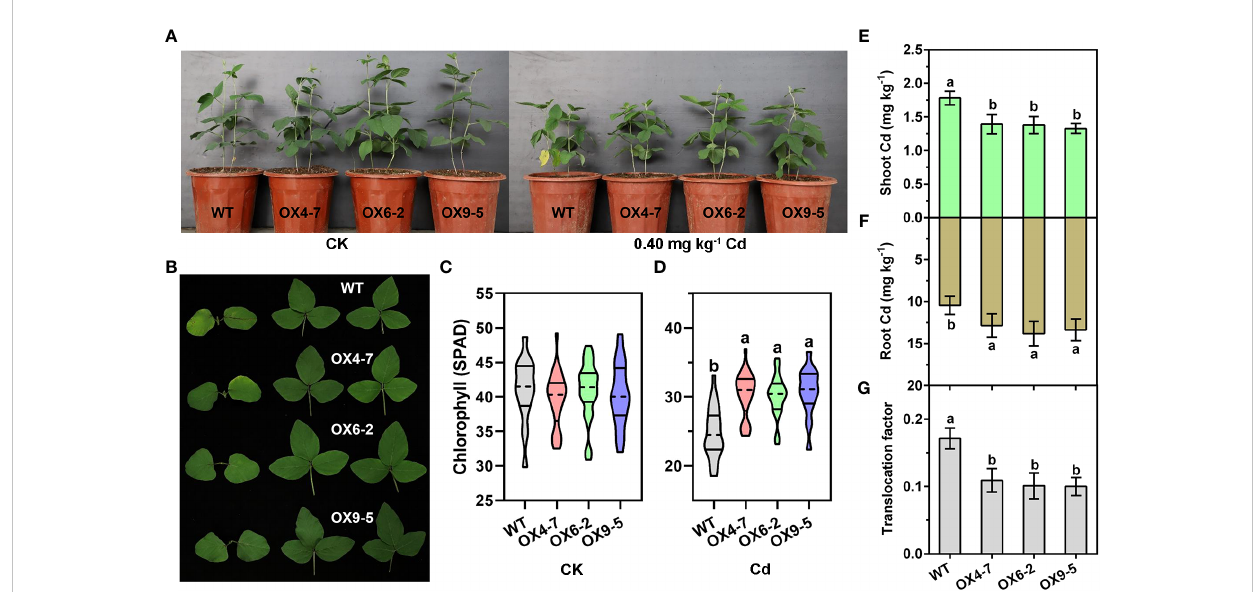
FIGURE 3 Overexpression of GmWRKY172 reduced Cd accumulation in the shoots of soybean. (A, B) Phenotypes of soybean transgenic lines (OX4-7, OX6-2, OX9-5) and WT under normal or Cd-treated conditions. OX refers to GmWRKY172 overexpression. The chlorophyll contents of each plant were measured under normal (C) or Cd-treated (D) conditions ( n = 30). Cd contents in the shoot (E) and root (F) of WT and transgenic lines were measured after 25 days of Cd treatment. (G) The root-to-shoot translocation factor of Cd (ratios of shoot/root Cd contents) in the WT and transgenic lines. Data are expressed as mean ± SD, n = 3 (E – G) . Different letters indicate statistical signi fi cance determined by one-way analysis of variance and Duncan ’ s test ( P ≤ 0.05).